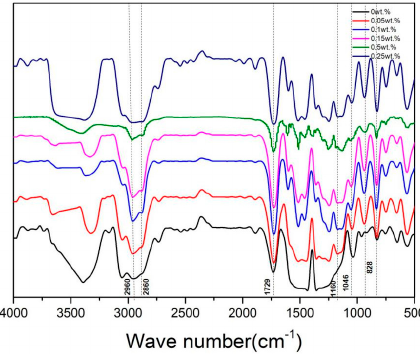
Figure 3. Fourier Transform infrared spectroscopy (FTIR) spectra of polymethyl